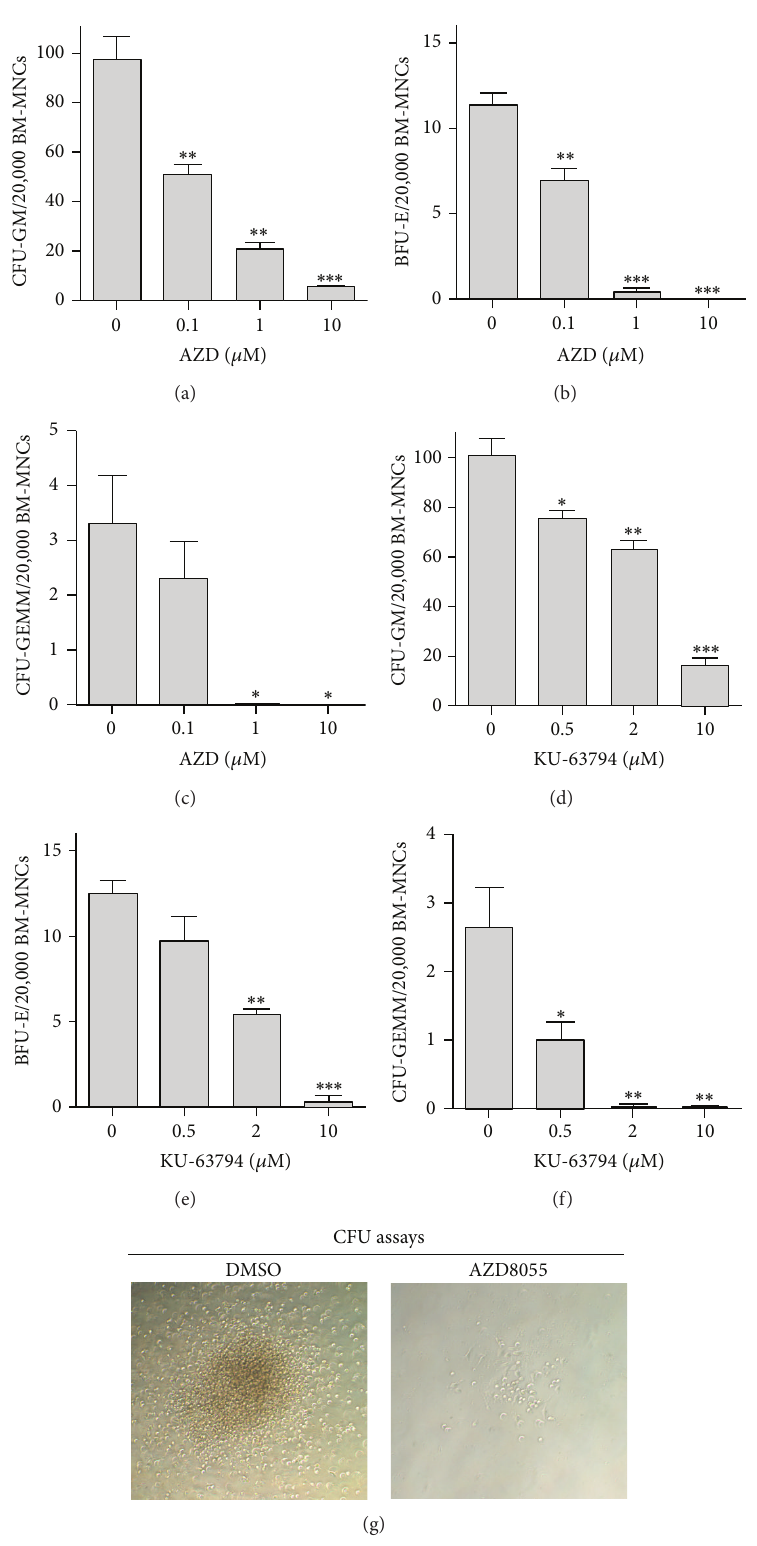
Figure 3: Treatment with dual mTORC1/2 inhibitors suppresses the clonogenic function of HPCs. Colony-forming unit (CFU) assays were performed to determine the functions of HPCs to generate CFU-E, BFU-E, and CFU-GEMM as we previously reported [14, 15]. (a–c) The effects of AZD on HPC functions were determined by CFU assays. (d–f) The effects of KU-63794 on HPC functions were determined by CFU assays. (g) Representative photomicrographs of CFU assays are shown. Data are presented as mean +/ − SEM of three independent experiments. ∗ 𝑝 < 0.05 ; ∗∗ 𝑝 < 0.01 ; ∗∗∗ 𝑝 < 0.001 versus DMSO vehicle